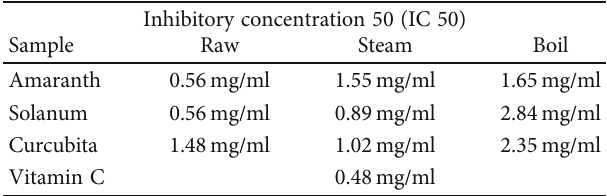
Figure 2: Hydrogen peroxide scavenging activity of the raw and cooked vegetables. Table 2: Antihemolytic activity of the raw and cooked